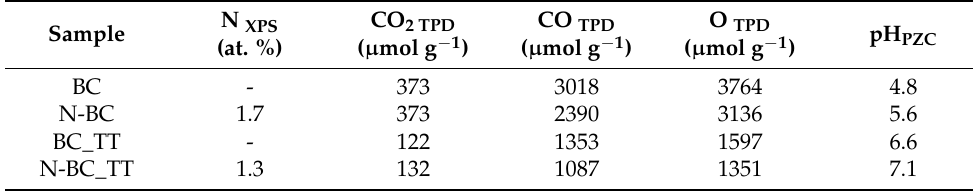
Figure 2. XPS N1s spectra of the N-BC and N-BC_TT. Table 2. Surface chemistry of the soft-biomass derived carbon